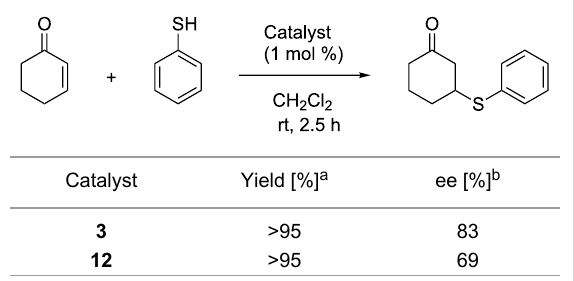
Table 3: Polymer-supported thiourea Cinchona organocatalyst in the asymmetric Michael addition.